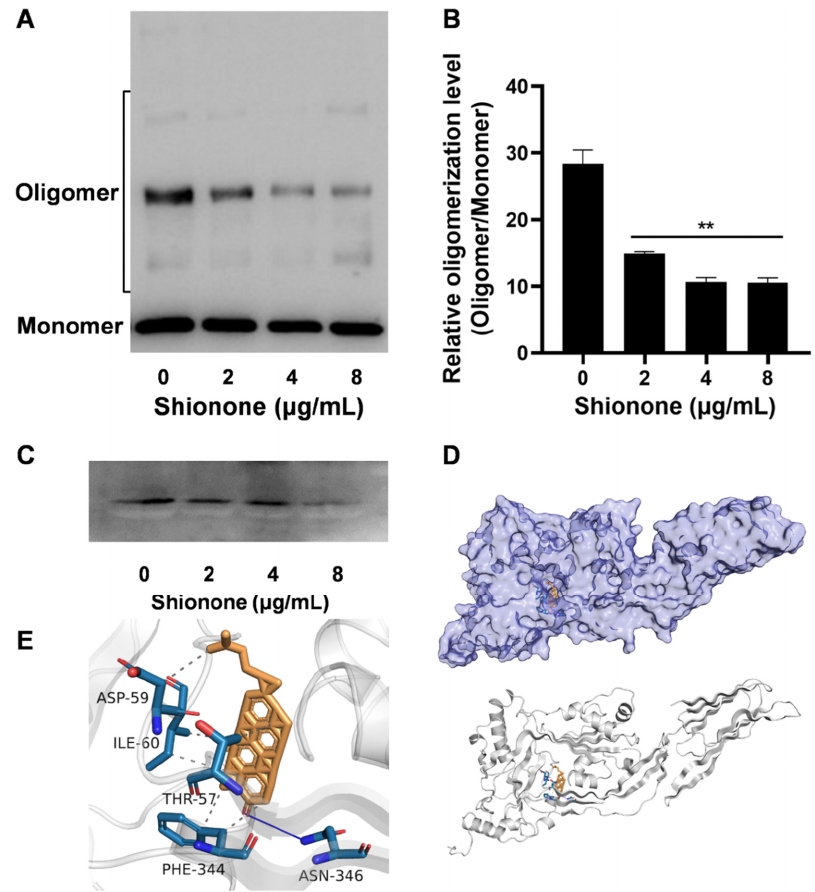
Figure 3. Shionone inhibits virulence of S. pneumoniae by targeting the oligomerization of PLY. ( A ) The oligomerization of PLY was detected by western blotting treated with or without shionone. ( B ) Densitometric analysis of PLY oligomerization with different concentrations of shionone treatment. ( C ) The expression level of PLY determined after S. pneumoniae was cocultured with different con- centrations of shionone for 6 h. ( D , E ) Shionone interacts with the active pocket of PLY and targets amino acid sites ASP-59, ILE-60, THR-57, PHE-344, and ASN-346. The significance level was ex- pressed as follows: ** p < 0.01. 2.4. Shionone Alleviates S. pneumoniae Virulence in Mice A pneumonia model induced by S. pneumoniae was established to explore the protec- tive effect of shionone in vivo. After infection for 48 h, significant lung tissue damage with a deep red color and congestion was observed in the model group compared to the control group (Figure 4A). Lung injury was ameliorated with 50 mg/kg shionone treatment, as shown in Figure 4A. The histopathological analysis of the model group demonstrated im- paired alveolar structure and inflammatory cell infiltration compared with the control, as shown in Figure 4B. In contrast, alveolar tissue in the treatment group was structurally intact, and associated inflammatory cell infiltration was reduced. Additionally, the results of the lung colony counting assay showed that shionone decreased S. pneumoniae lung colonies by approximately 4 × log 10 units compared with the model group, as shown in